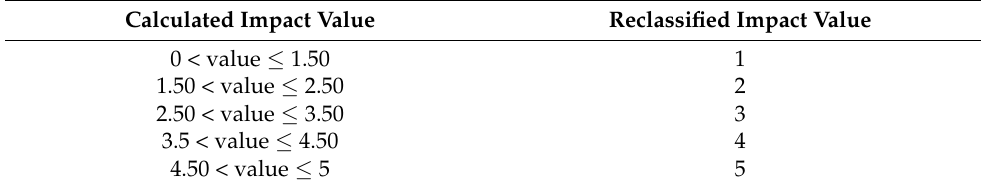
Table 15. Criteria applied to group the values of environmental impact by